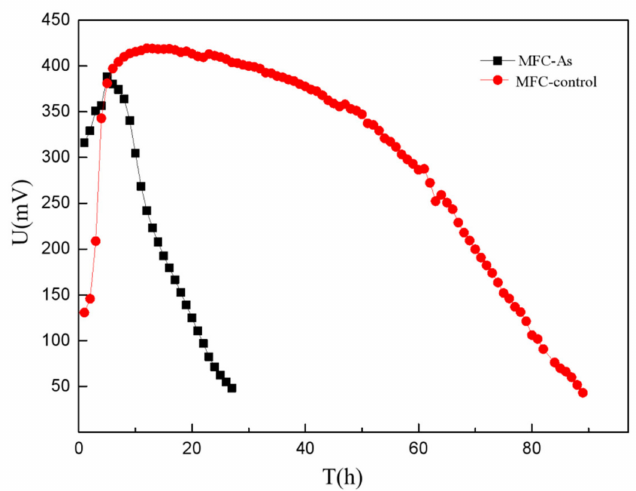
Figure 2. Output voltage comparison of the MFC during the stable operation